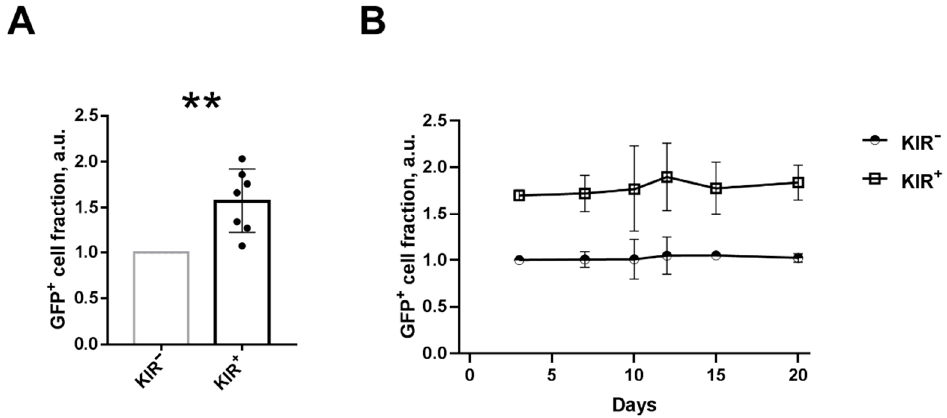
Figure 1. The transduction of NK cell subsets differing in KIR2DL2/3 expression. ( A ) The GFP + cell fraction in sorted KIR2DL2/3 + and KIR2DL2/3 − NK cell subsets, 5 days after the transduction. The averaged data from different donors ( n = 8) are presented. ( B ) Dynamics of the GFP + cell fraction in KIR2DL2/3 + and KIR2DL2/3 − NK cell subsets after the transduction ( n = 2). The GFP+ cell fraction was measured in arbitrary units (a.u.) as the GFP level in the KIR2DL2/3 + subset divided by the GFP level in the KIR2DL2/3 − subset for each donor. In this and the following figures, KIR2DL2/3 is designated as KIR. Statistical analysis was performed using the paired t -test (** p < 0.01); means ± SE are shown.